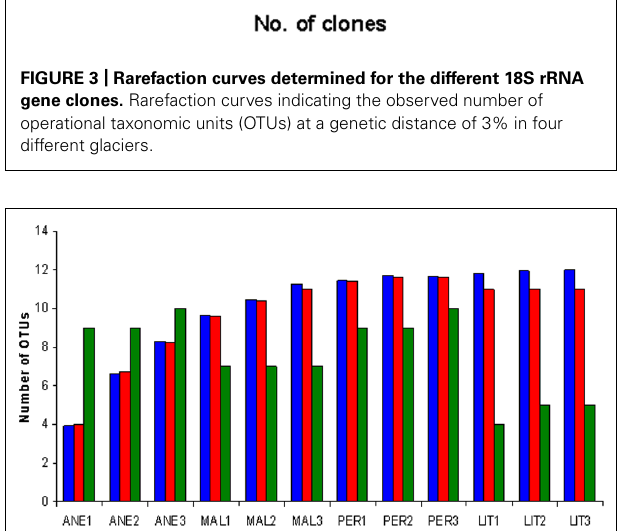
FIGURE 4 | Richness estimates of Pyrenean glaciers at a genetic distance of 3%. Richness has been estimated by the richness estimator Chao1, which is a non-parametric richness estimator based on distribution of singletons and doubletons (blue), by the abundance-based coverage estimator (ACE), which is a non-parametric richness estimator based on distribution of abundant ( > 10) and rare ( < 10) OTUs (red), and by the number of OTUs (green). Sample numbers are given below the graph. A description of the samples is shown in Table 2